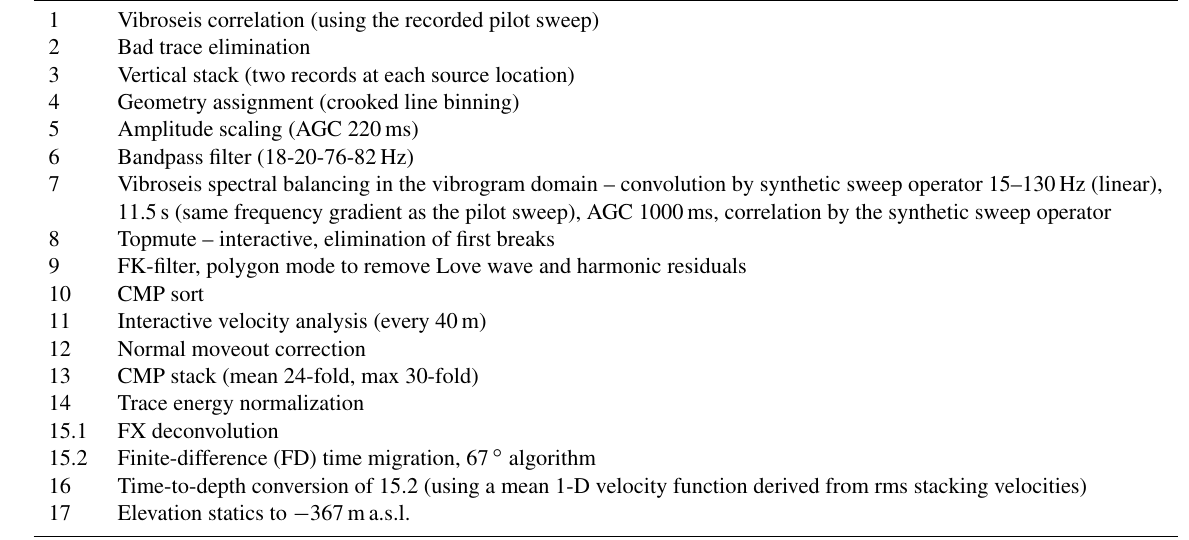
Figure 5. Examples of recorded shot gathers (automatic gain control – AGC of 220ms window; amplitude scaling and bandpass filter (18- 20-76-82Hz) applied) in the time domain along profile 1b. The positions of the seismic source are labelled by orange stars. FFID denotes the record number along the profile; CHAN denotes the geophone number along the land streamer unit. Arrows at top denote the condition of the ground surface observed along the profile. In the northeast, close to the sinkhole-affected area, first break and reflection signals are weak due to the strong wave scattering in the subsurface caused by material loosening and cracking. The situation improves towards the southeast, where no sinkholes or other subsidence features were present during profiling and the road surface was in good condition. Below, mean amplitude spectra of the time window 0–400ms (estimated 0–70m depth) for each record are shown. Table 1. Reflection seismic data processing